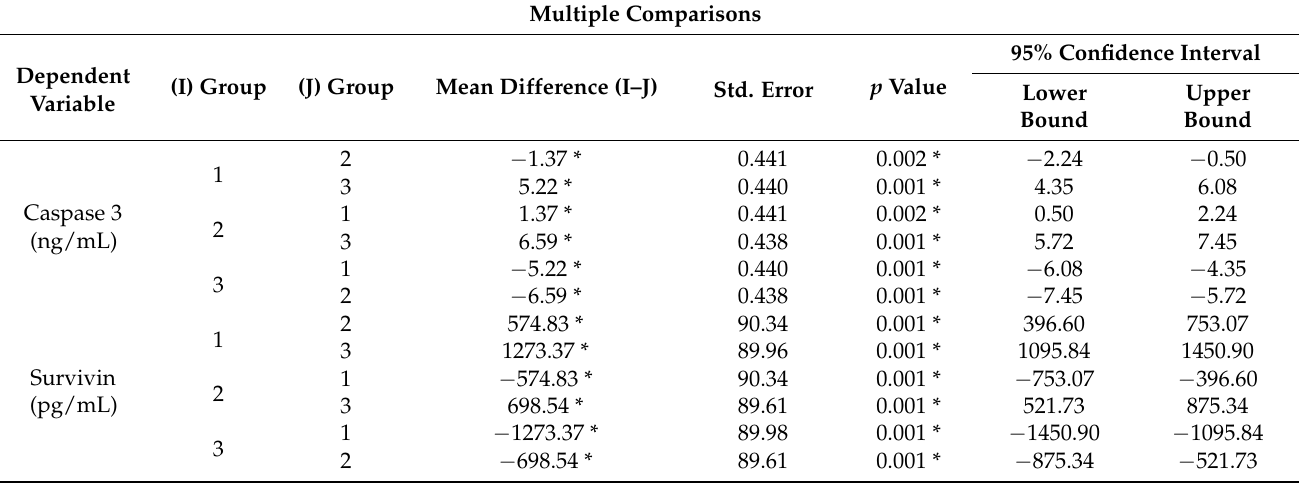
Table 2. Shows the ANOVA to test the significance of difference in the variables across the groups. Multiple